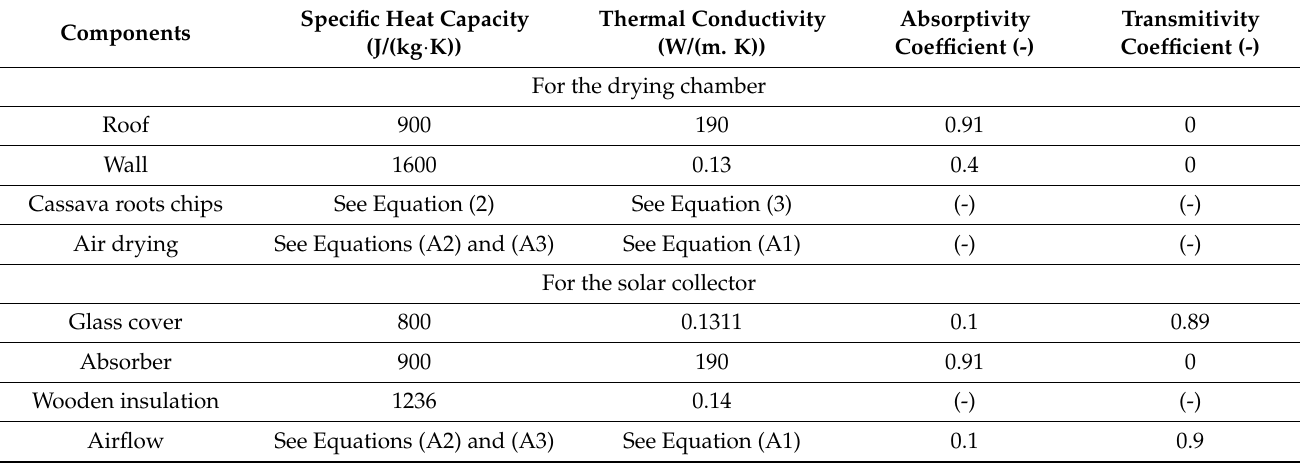
Table 3. Thermal properties of the components of solar dryer